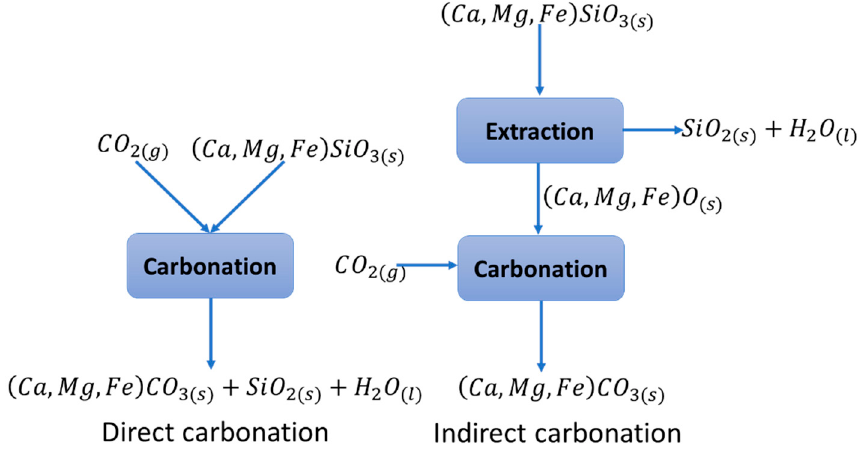
Figure 1. Direct and indirect carbonation gas–solid routes (adapted from Olajire [5]).